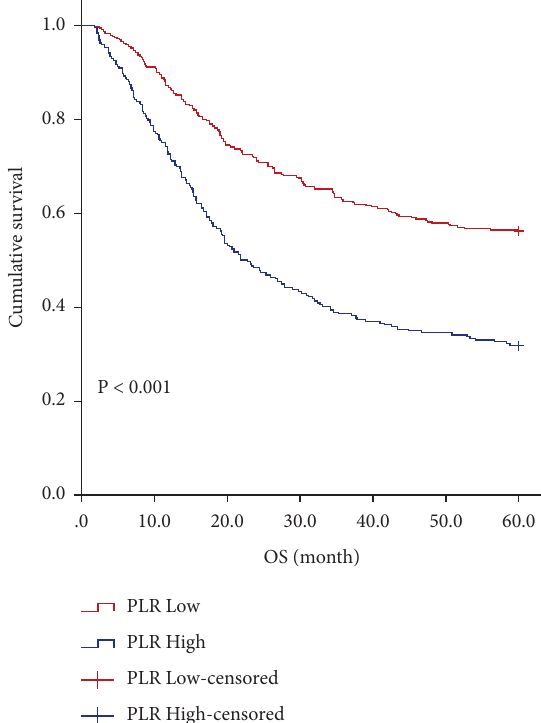
Figure 1: Kaplan–Meier analysis of OS for the PLR of all patients with gastric cancer.